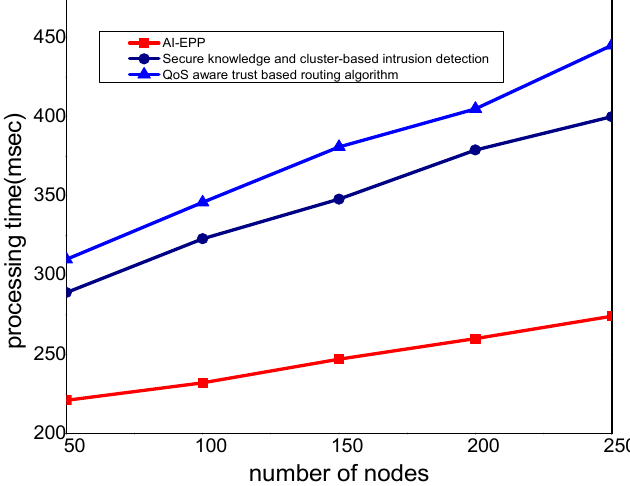
Figure 14. Link disconnectivity comparison using simulations with varying data rates.